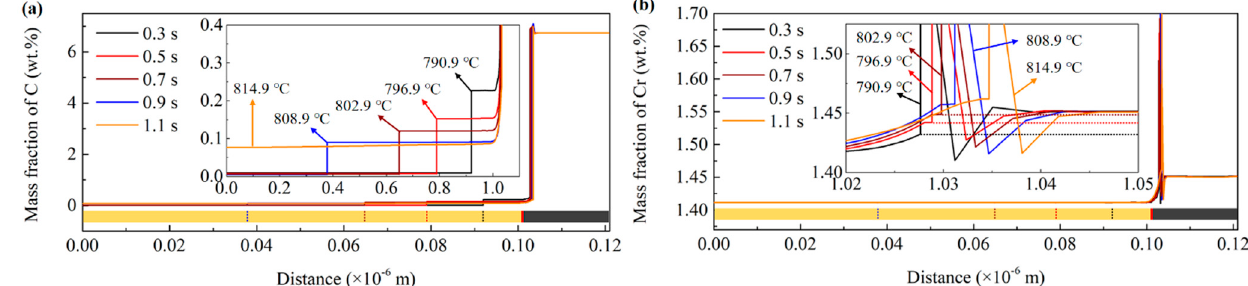
Figure 7. Temporal evolutions of the concentration distributions of ( a ) C and ( b ) Cr simulated with the DICTRA software.